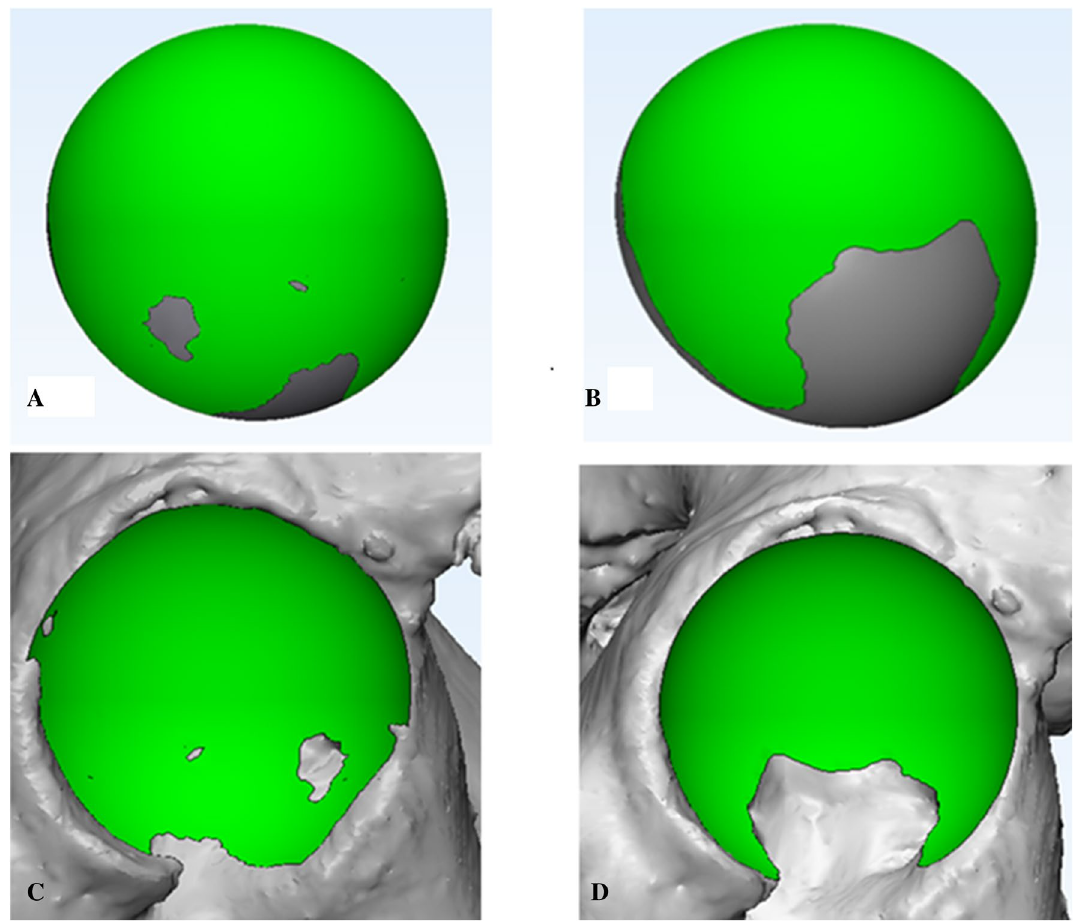
Figure 3. Interfaces between the cup component and the host acetabulum. ( A , B ). Cup coverage with the conventional reaming technique ( A ) and with the anatomical technique ( B ). ( C , D ). The interface on the acetabulum with the conventional reaming technique ( C ) and with the anatomical technique ( D ).